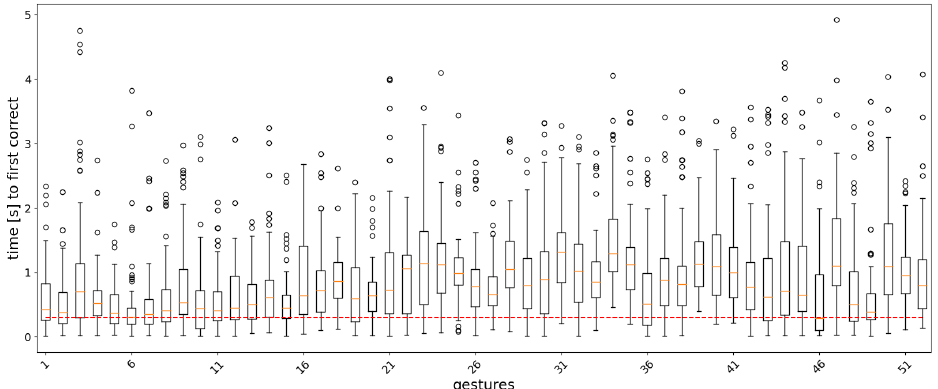
Figure 6. Boxplots of the distribution of the time to the first correct prediction per gesture for the AoT300 model. The boundaries of the boxes correspond to the Q1 and Q3 quartiles, the boundaries of the standard deviations are Q1 − 1.5IQR and Q3 + 1.5IQR, where IQR = Q3 − Q1, and the circles correspond to outliers.The red dashed line corresponds to 300